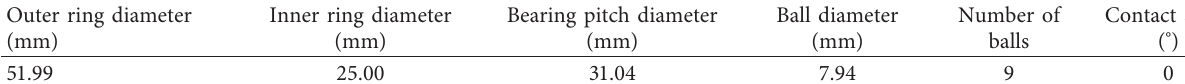
Table 2: The structural parameters of rolling